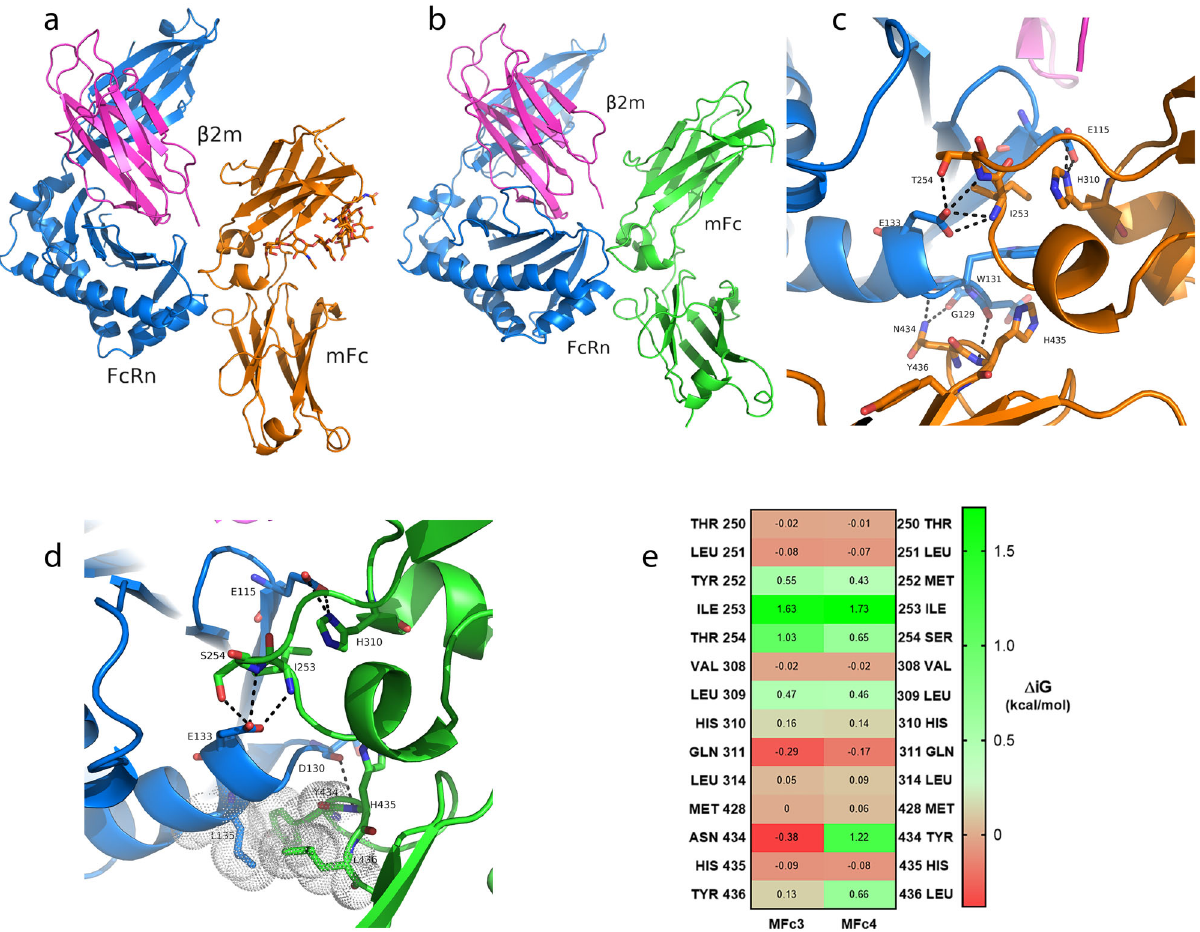
Fig. 4 Structural interrogation of FcRn interaction with MFc3 and MFc4. a MFc3 (orange) and FcRn (blue)/ β 2-macroglobulin (pink) complex were crystallized in the C2221 space group with cell parameters a = 68.10 Å, b = 122.10 Å, c = 179.45 Å, Matthews parameter V M = 2.87 Å 3 /Da, solvent content of 57.2%, and one complex per asymmetric part of the unit cell. b Binding interface between MFc3 (orange) and FcRn (blue). Hydrogen bonds are indicated by dashed lines. c MFc4 (green) and FcRn (blue)/ β 2-macroglobulin (pink) complex were crystallized. d Binding interface between MFc4 (green) and FcRn (blue). Hydrogen bonds are indicated by dashed lines. e Heat map showing the differential solvation energy Δ iG (kcal/mol) contribution from each MFc residue involved in the receptor-binding interface. Higher positive values indicate a stronger solvation effect from the monomeric Fc bound